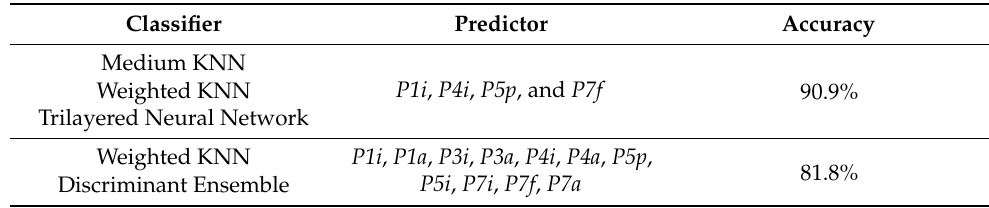
Table 3. Results of classification